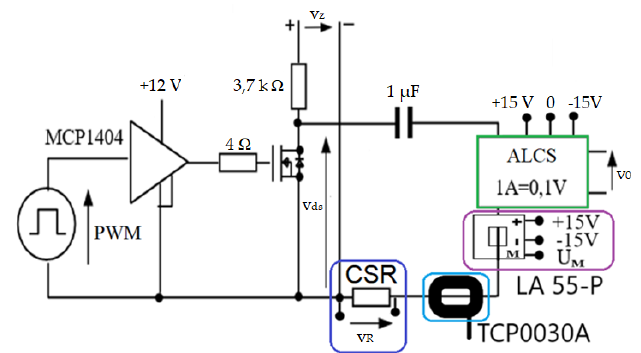
Figure 6. Capacitor discharging circuit as an impulse current generator circuit. All current sensors have been marked on the figure: ALCS, LA 55-P, TCP0030A [22], and the low-inductance current shunt resistor, CSR.